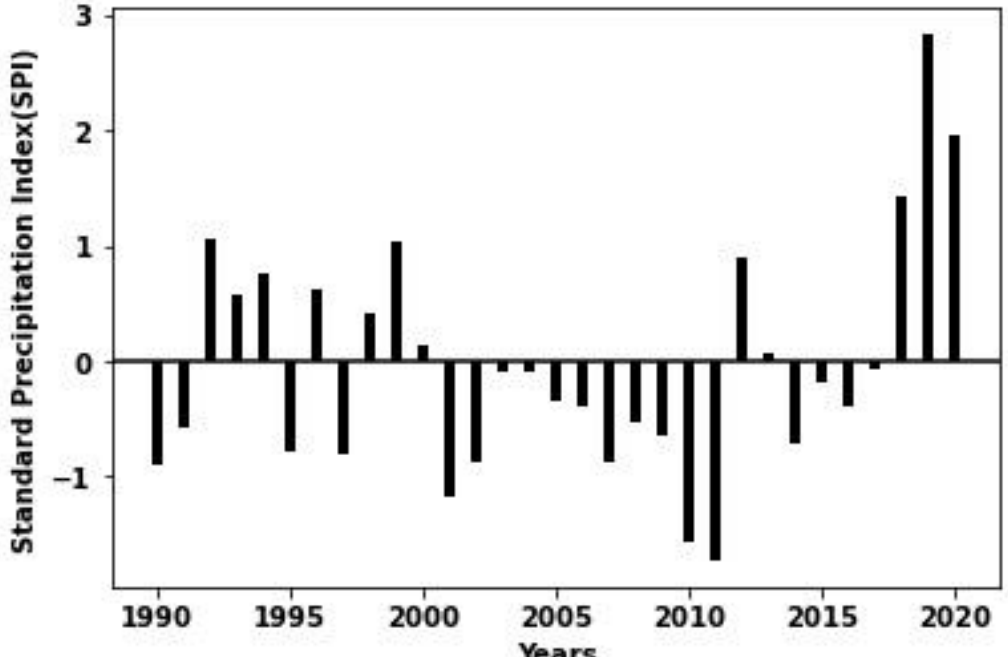
Figure 3: Standard precipitation indexes for Gombe between 1990 and